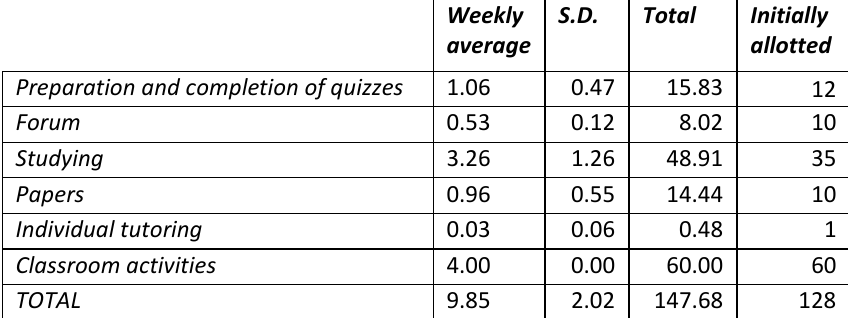
Table 2. Average weekly workload of students in the five-years study.